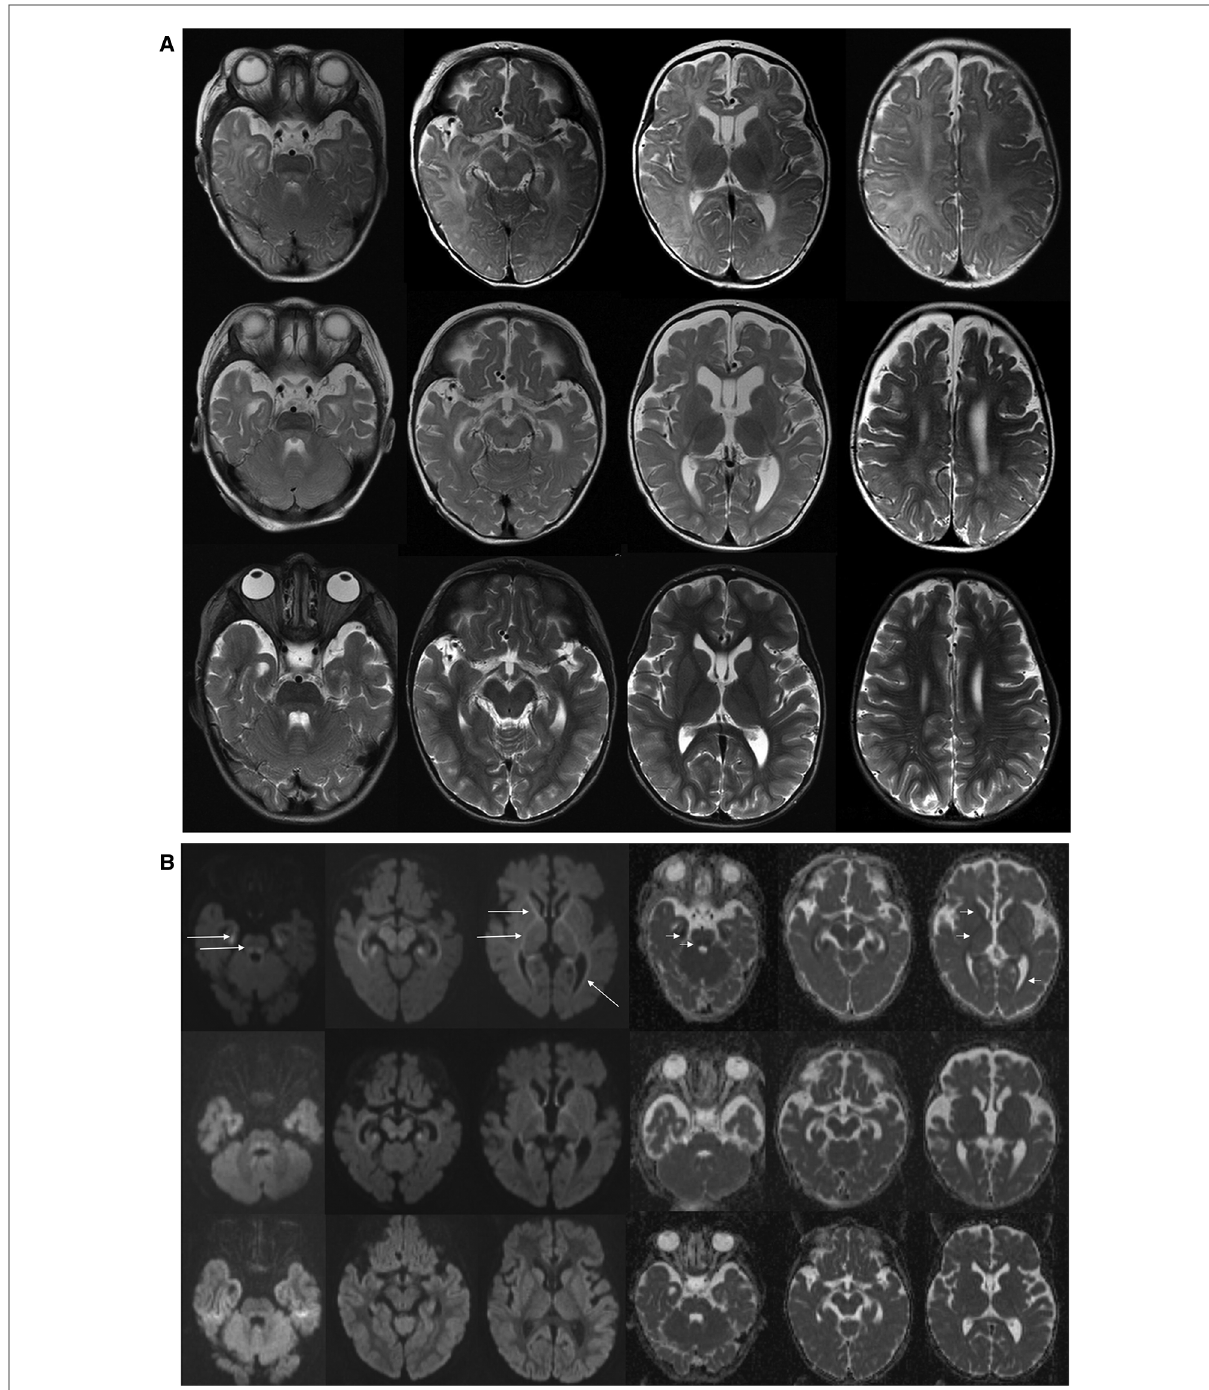
FIGURE 2 Brain MR examinations performed at 6 months (upper row), 14 months (middle row), and 5 years (bottom row). ( A ) Axial T2-WI. T2-weighted images at 6 months showed delayed brain myelination; on follow-up examination at 14 months, myelination was progressed, but it still incomplete. On last examination at 5 years, myelination was complete. Brainstem with tegmental hyperintensity was seen at 6 and 14 months and was almost completely resolved at 5 years. Width Virchow – Robin spaces appeared at 5 years. ( B ) Axial DWI (diffusion weighted images with b=1000) and ADC maps. At 6 months, abnormal restricted diffusion (hyperintense in DWI — long arrows and hypointense in ADC maps — short arrows) involving anterior and posterior limbs of internal capsules, anterior parts of external capsules, mesial temporal white matter, optic radiations were seen. Restricted diffusion in the cerebral peduncles as well as in the central tegmental tracts and superior cerebellar peduncles are shown. At 14 months, images showed milder degree of residual restricted diffusion which returned to normal at 5 years. ADC, apparent diffusion coef fi